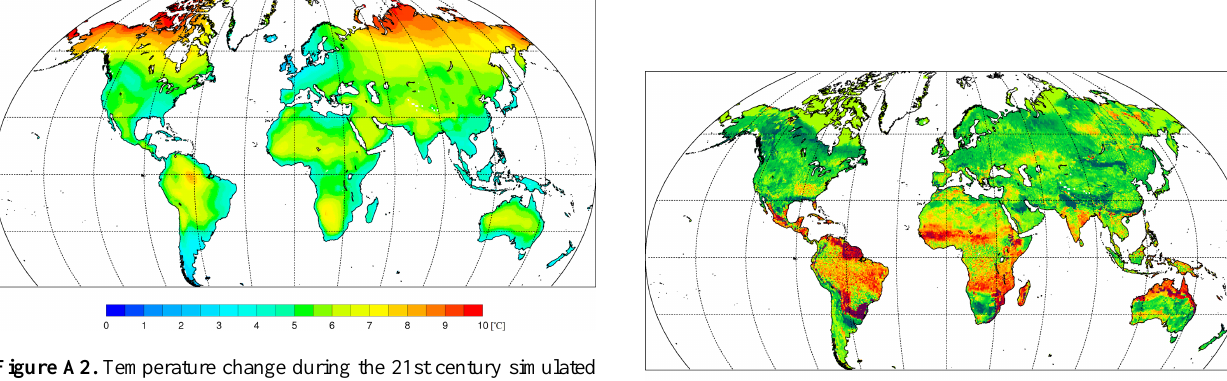
Figure A2. Temperature change during the 21st century simulated with MPI-ESM-LR under RCP 8.5. Shown is the difference be- tween average values computed for 1990–2000 and 2090–2100. Data were bias-corrected following Ahlström et al. (2013).